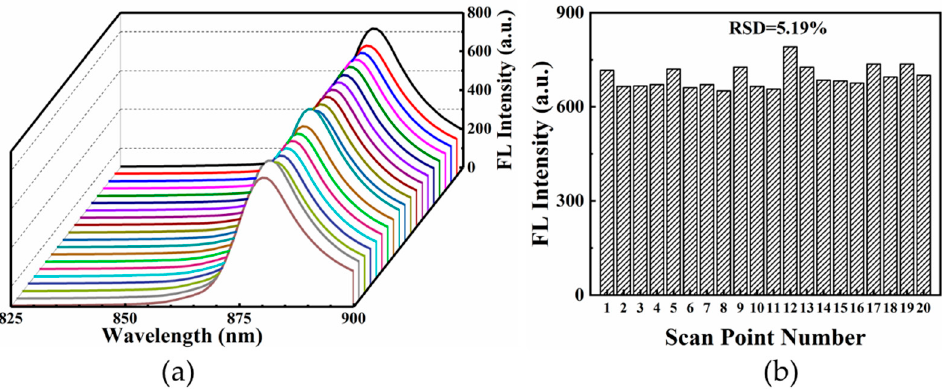
Figure 9. ( a ) Fluorescence spectra of 10 − 10 mol / L CV absorbed on hierarchical LIPSS collected from twenty randomly selected acquisition points from substrates; ( b ) the RSD of the integrated fluorescence intensity of CV at 880 cm − 1 .